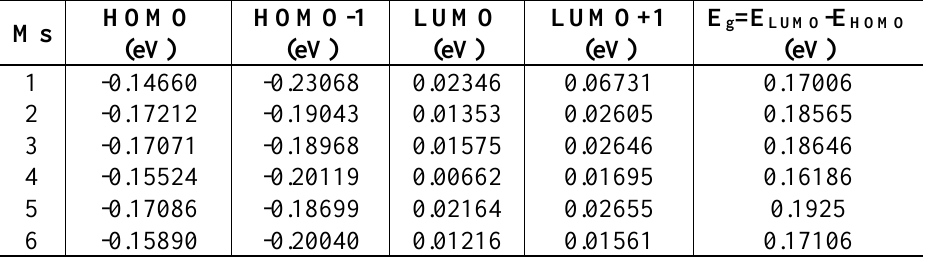
, E , E , E and E in eV of six molecular structures. HOMO HOMO-1 LUMO LUMO+1, gap